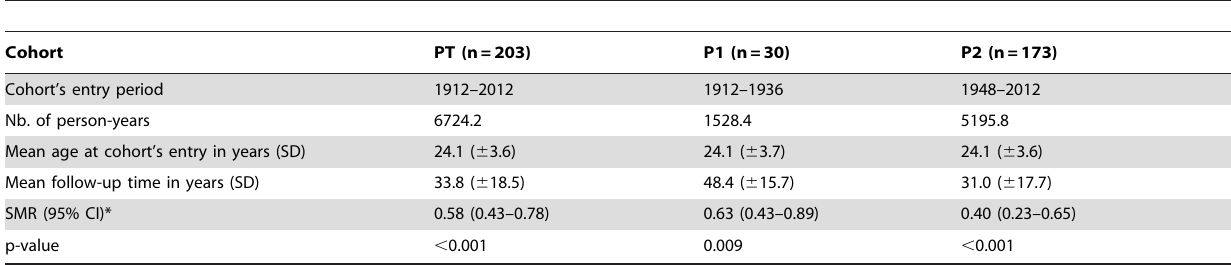
Table 1. French Olympic rowers’ cohort description and their overall mortality compared with the French general population.